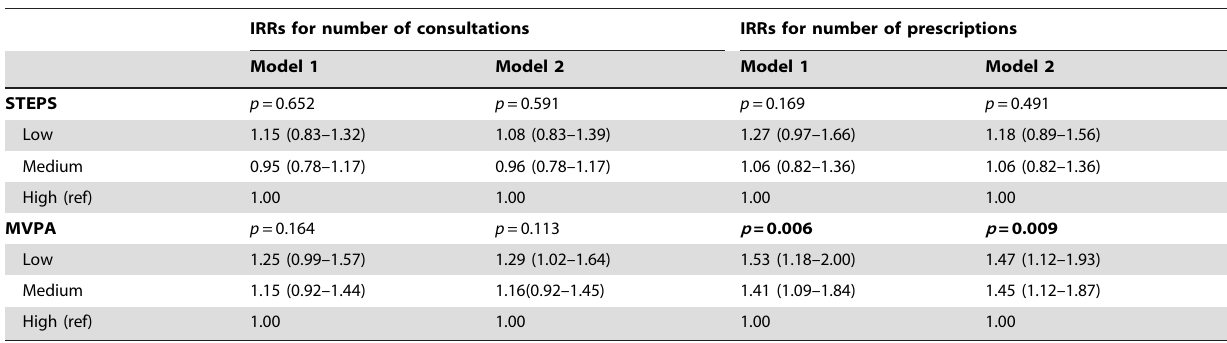
Table 3. Negative binomial regression predicting use of consultations and prescriptions based on measures of physical activity.